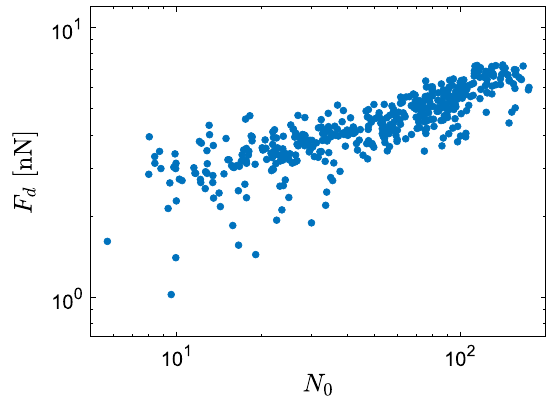
FIG. 9. Drag force F d on a particle on the perimeter of a raft, estimated using a linear drag model, as a function of the total number of particles in the raft, N 0